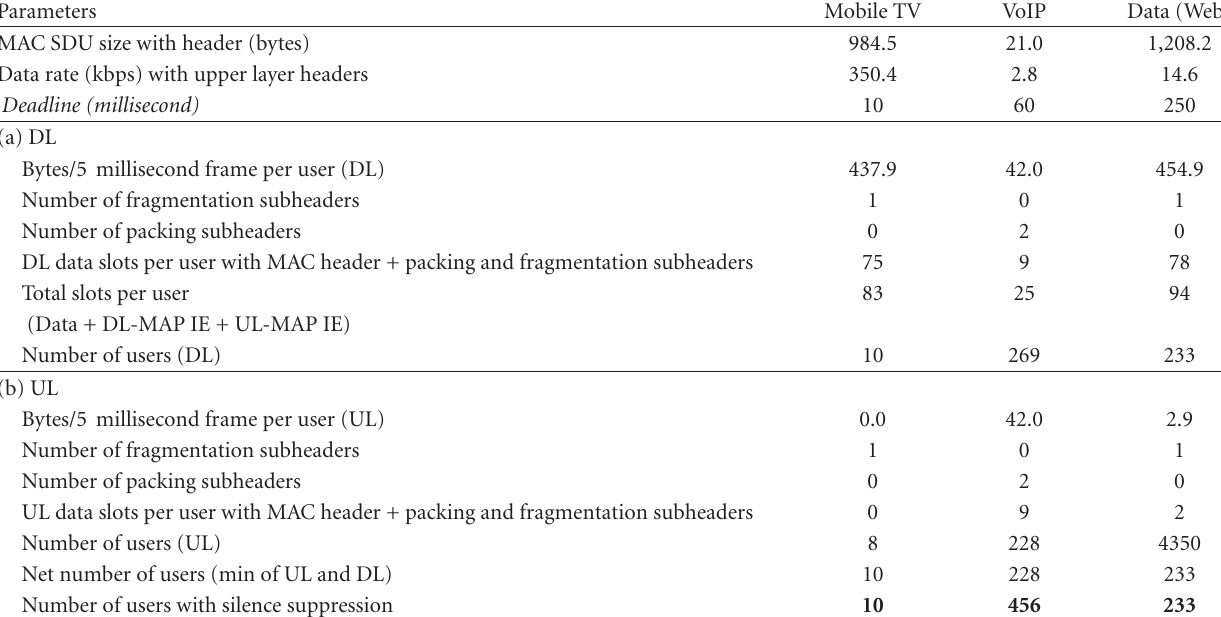
Table 11: Example of capacity evaluation using an enhanced